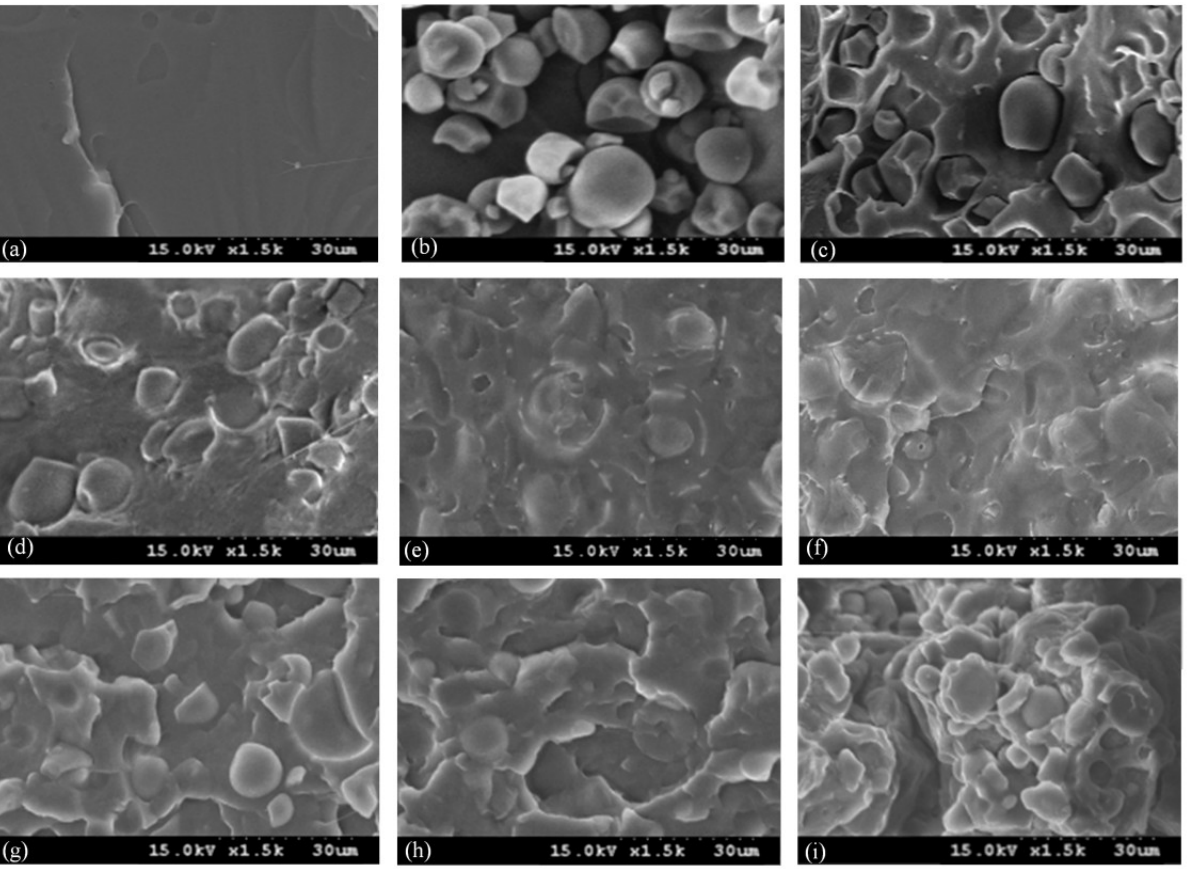
tapioca ; ( d ) PLA 70 30